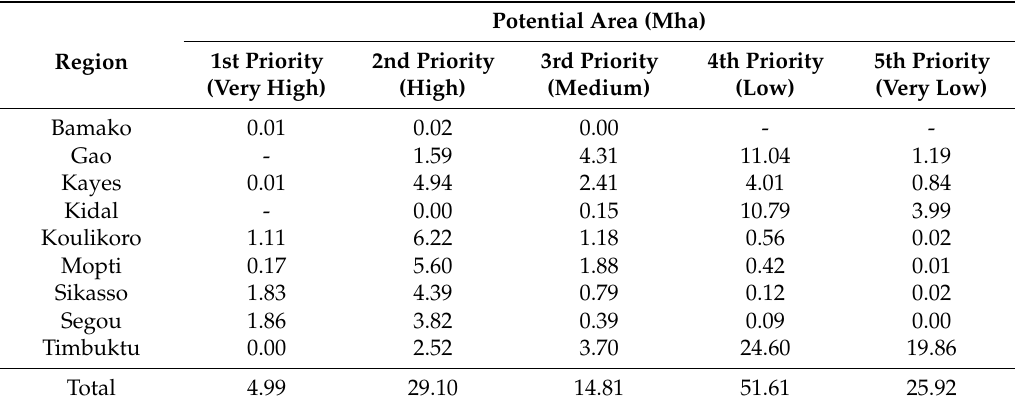
Table 4. Potential areas for watershed